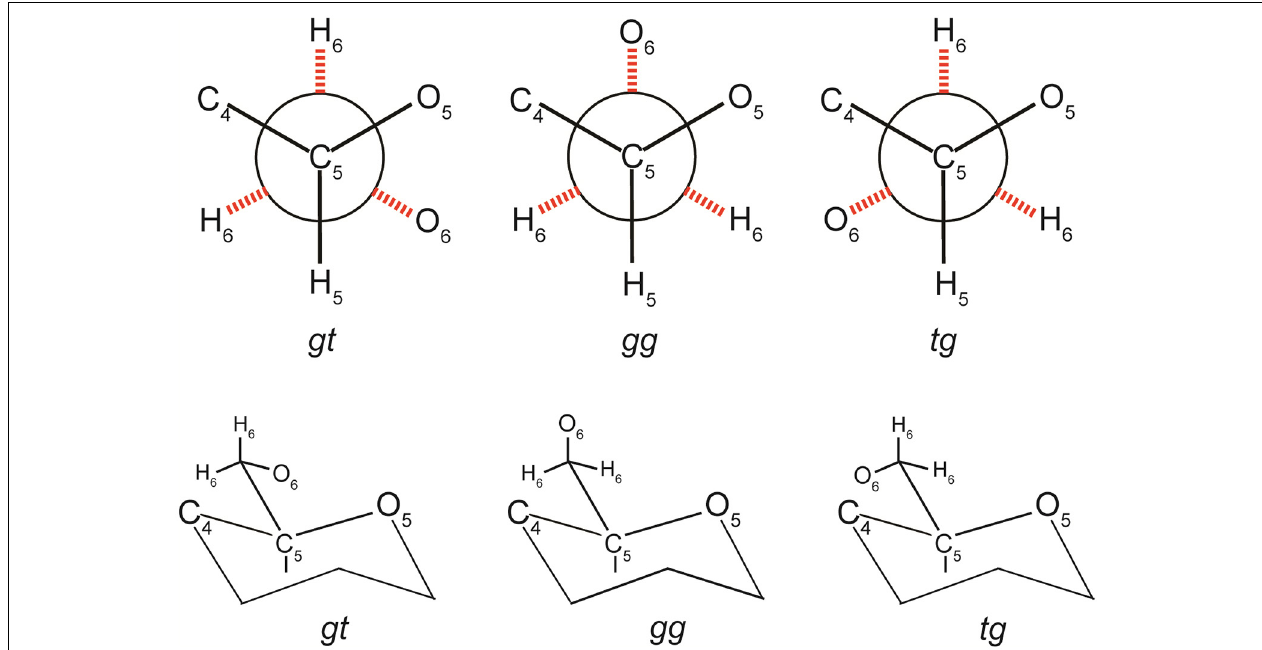
FIGURE 8 | Conformations of CH 2 OH group— gt , gg , and tg